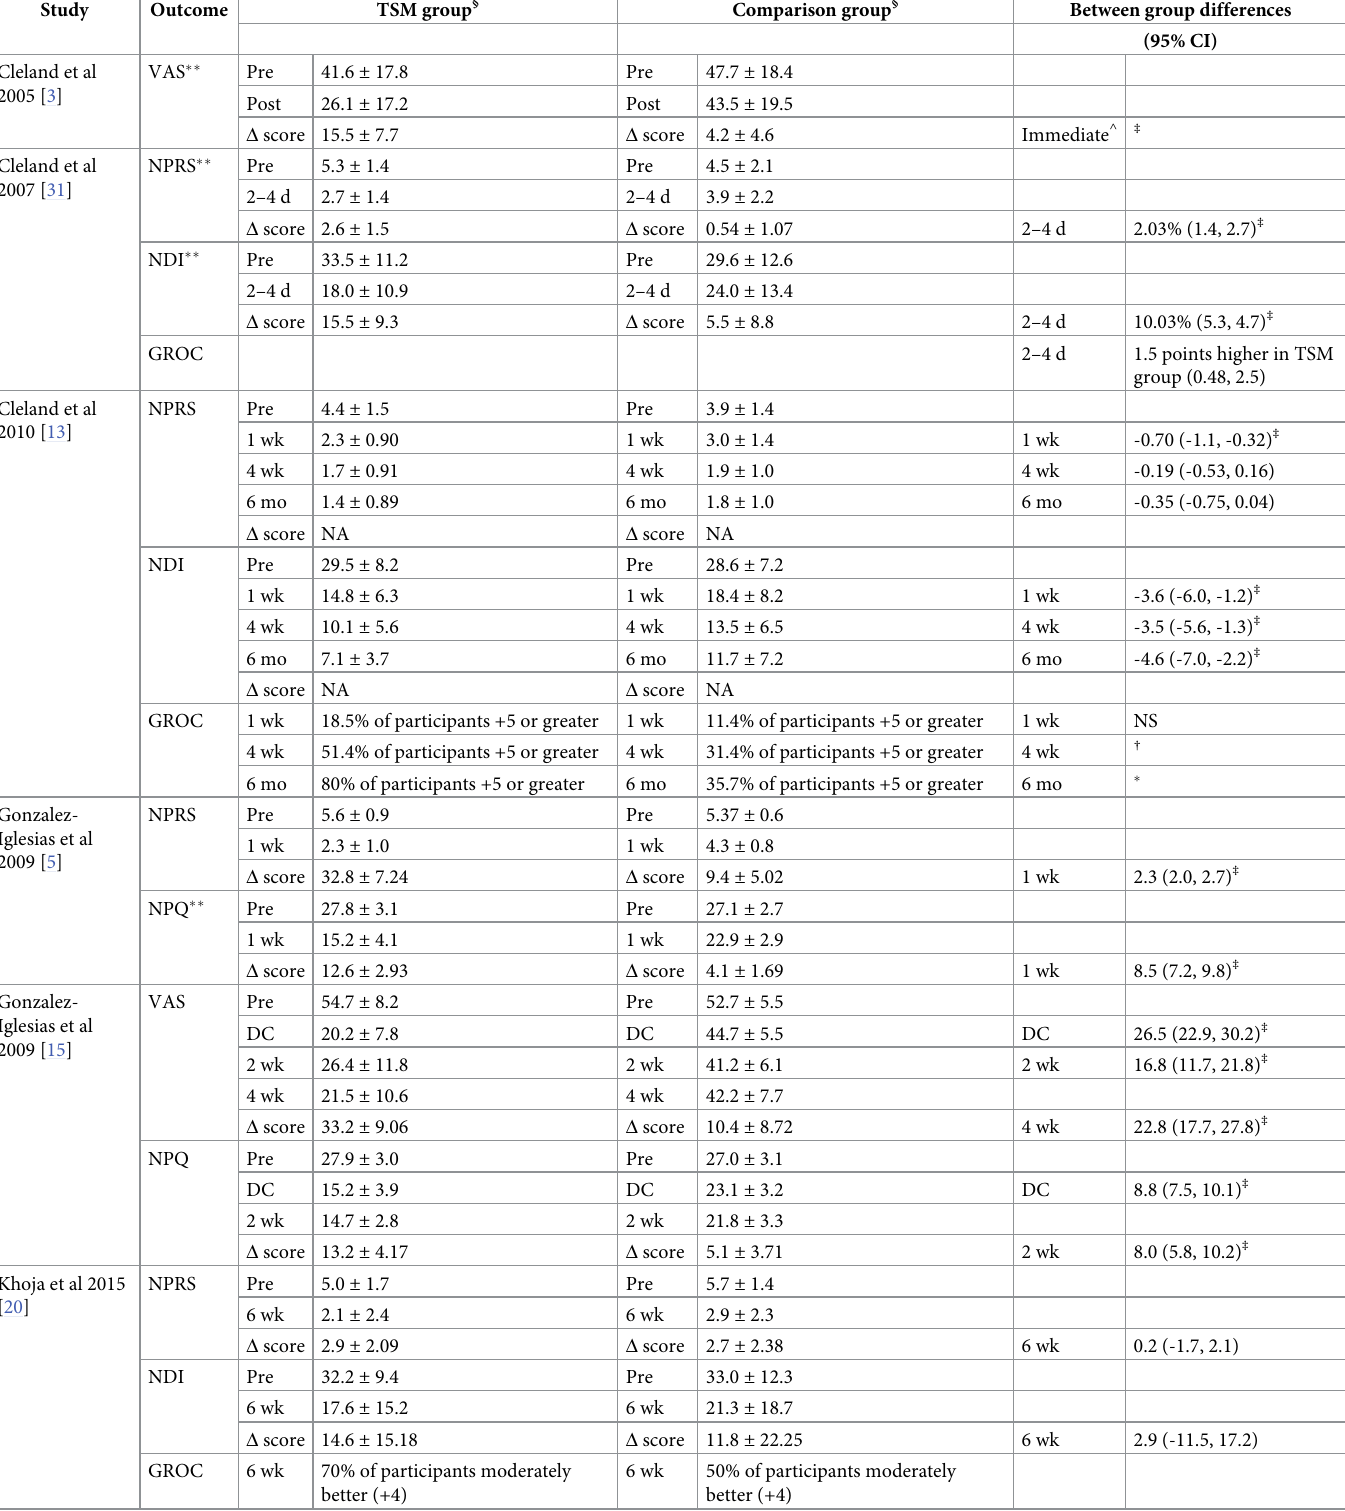
Table 4. Results of included